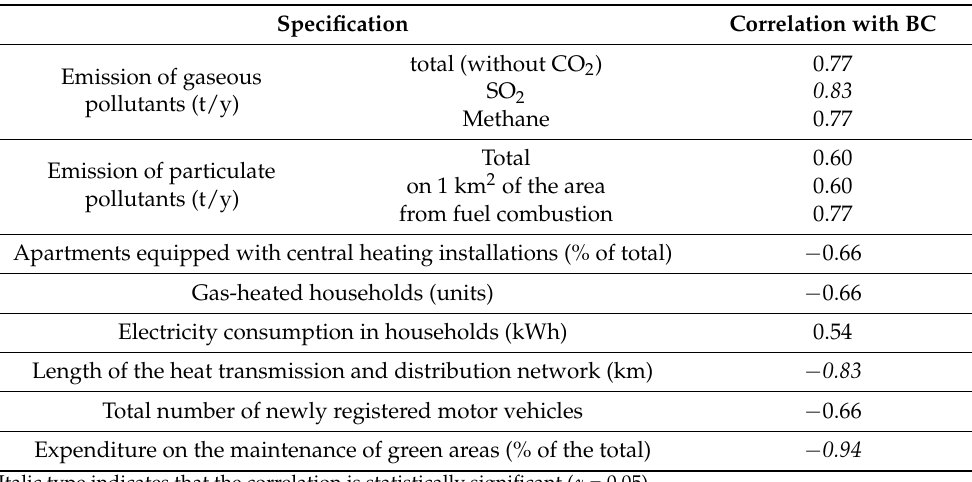
Table 5. The results of the Spearman correlation analysis ( α = 0.05) between concentrations of eBC and CSO statistical parameters for the city of